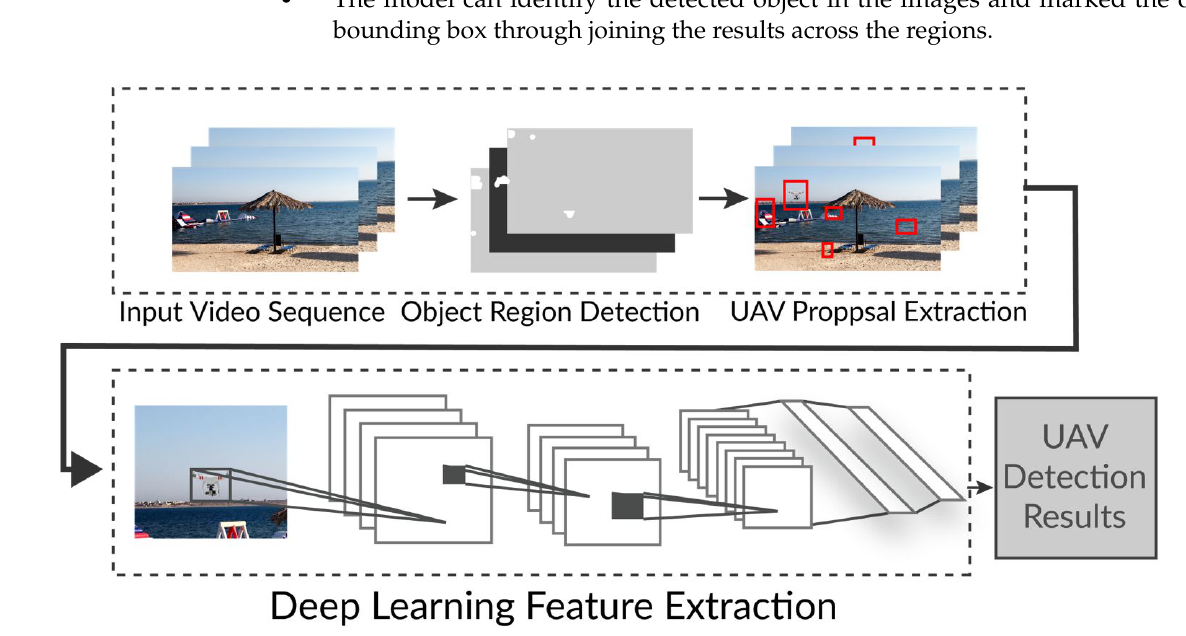
Figure 1. Typical drone detection based on deep